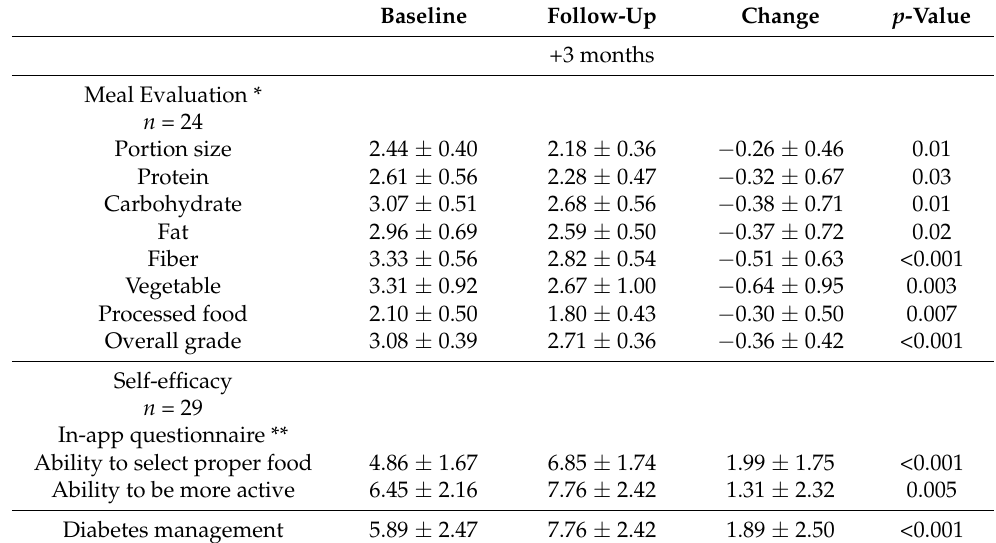
Table 4. Effects on App Reported